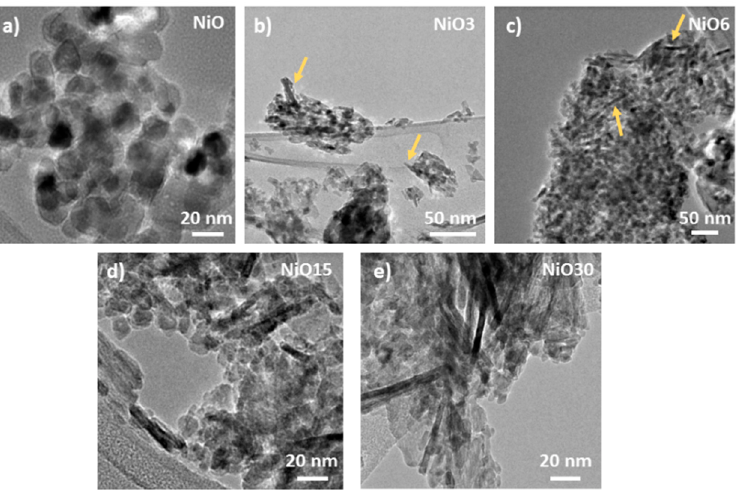
Figure 3. TEM images from ( a ) undoped NiO sample, ( b ) NiO3 sample, ( c ) NiO6 sample, ( d ) NiO15 sample and ( e ) NiO30 sample